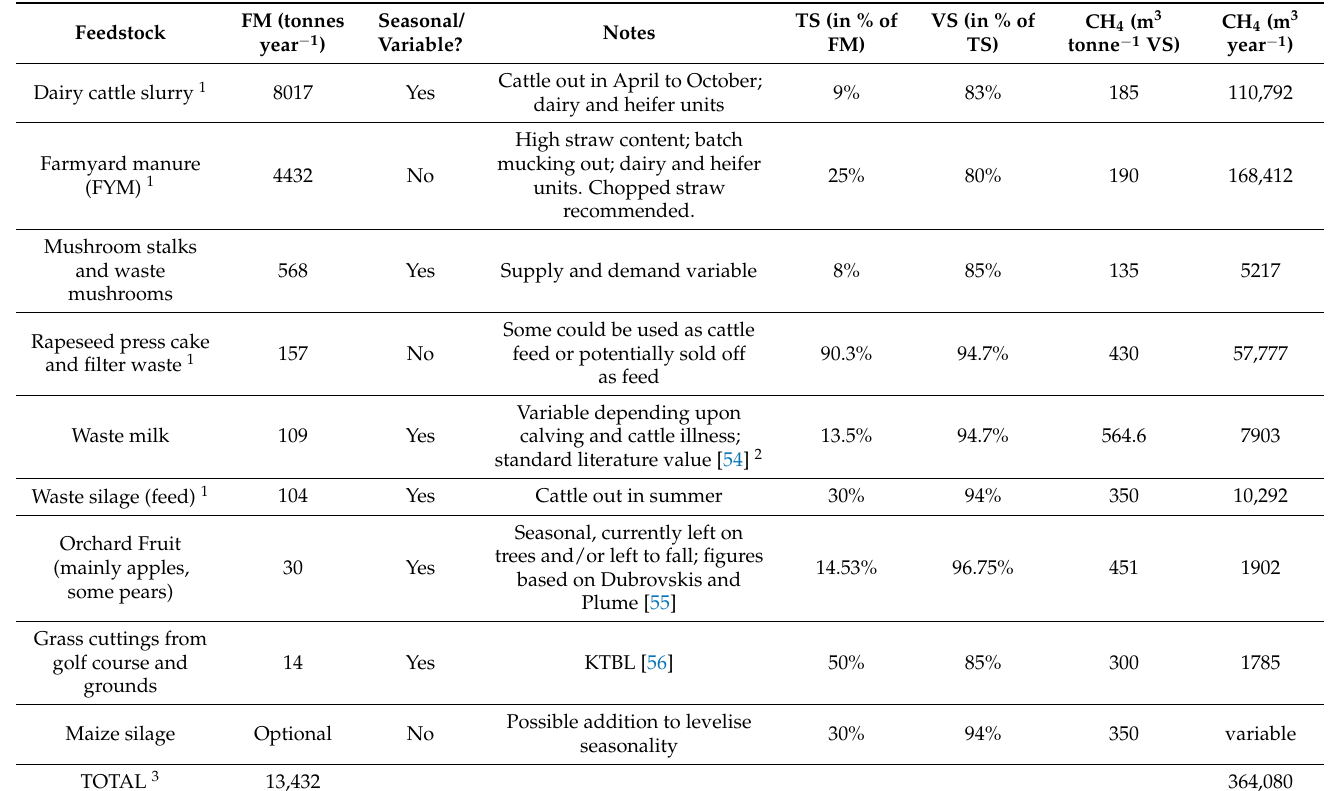
Table 3. Potential AD feedstocks and corresponding methane